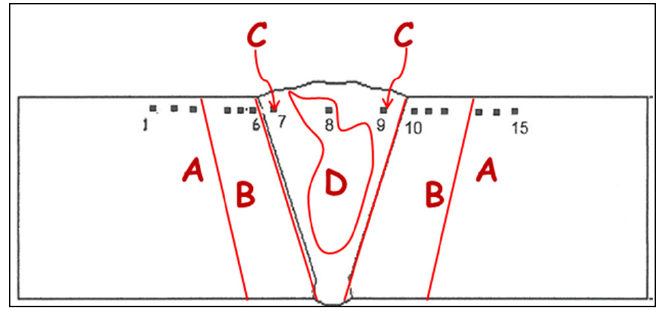
Figure 4. The measurement of Vickers microhardness for the FSW joint: A: Unaffected material; B: Heat affected zone (HAZ); C: Thermo ‐ mechanically affected zone (TMAZ); and D: Weld nugget (Part of thermo ‐ mechanically affected zone).